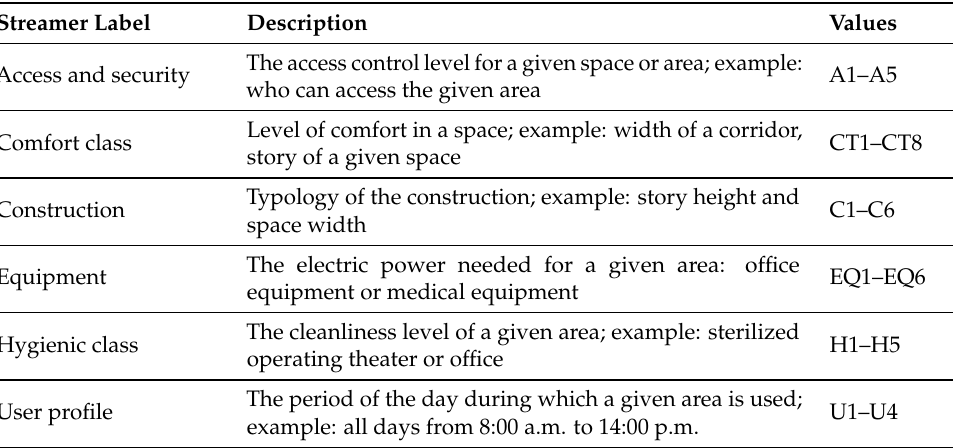
Table 1. Healthcare labels defined in the STREAMER